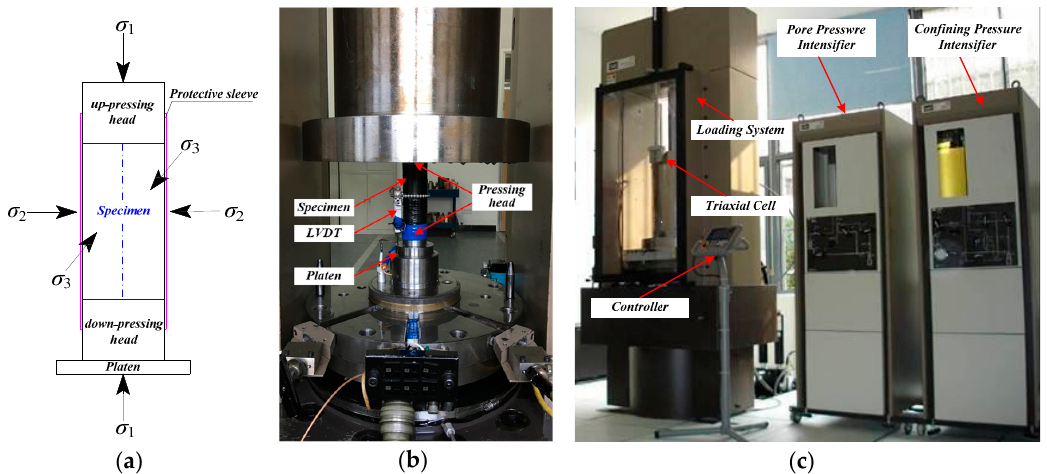
Figure 3. MTS815.03 Electro-hydraulic servo-controlled rock mechanics testing system. ( a ) loading state; ( b ) Test set-up; ( c ) loading system.